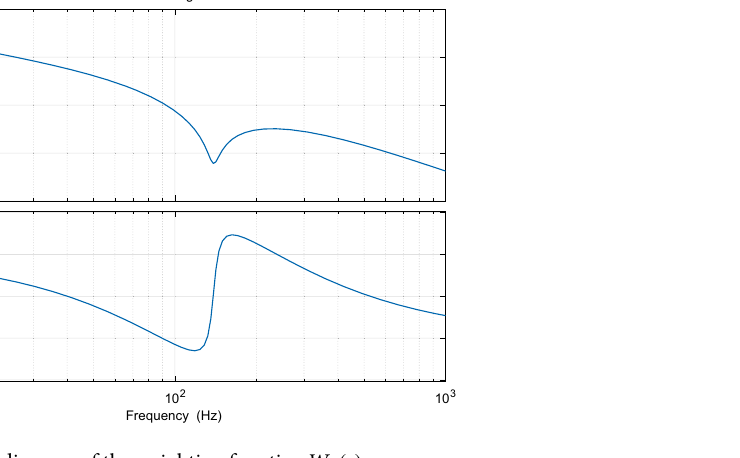
Figure 7. Bode diagram of the weighting function W 1 ( s )